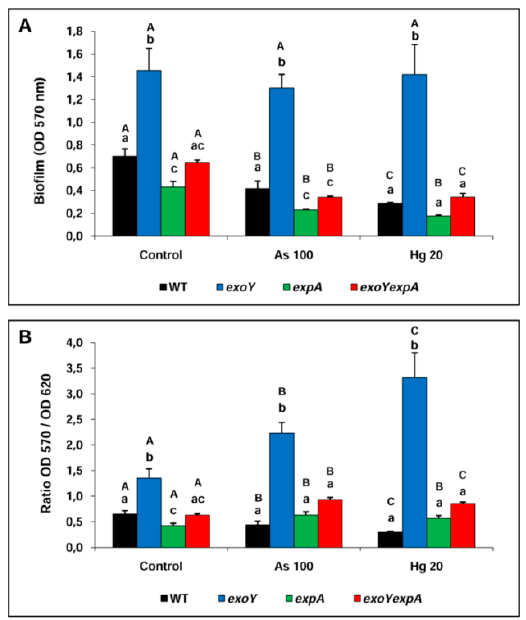
Figure 2. Bacterial biofilm formation ( A ); and relation between biofilm formation and planktonic growth ( B ) of S. meliloti strains in control and exposed to heavy metal conditions. Different small letters indicate statistic differences between strains of a same condition according to Fisher’s LSD test ( P < 0.05). Different capital letters indicate statistic discrepancies between conditions for a given strain according to Fisher’s LSD test ( P < 0.05).